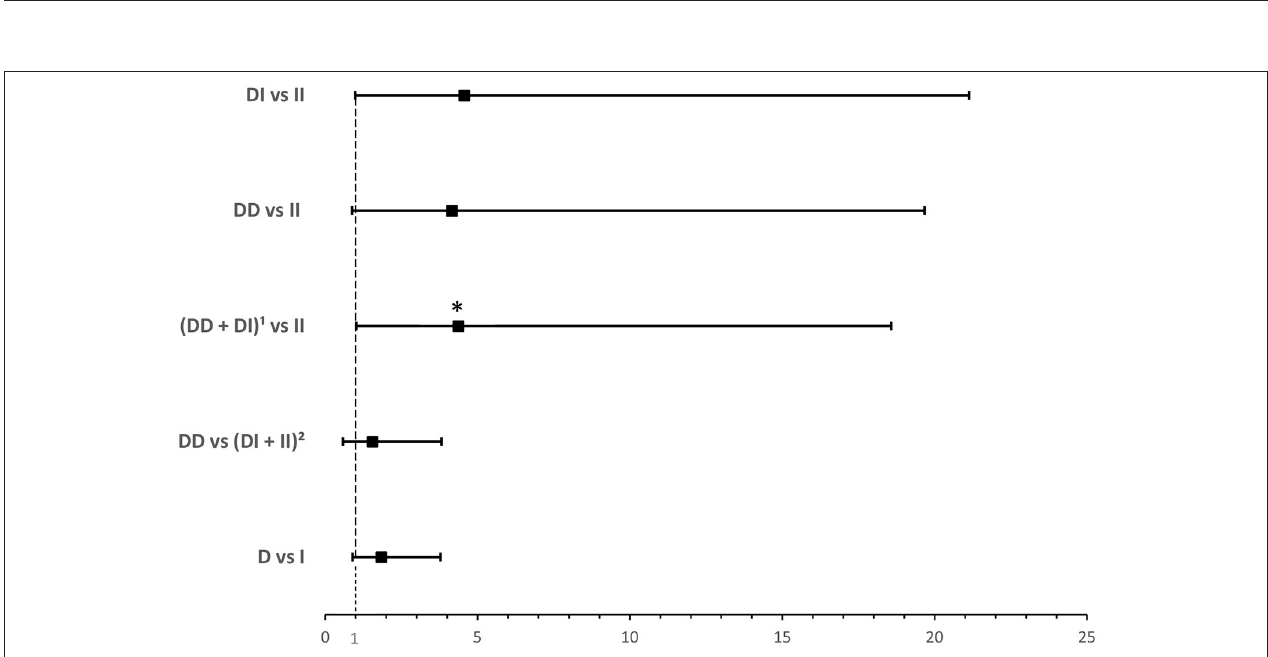
FIGURE 4 | Forest plot showing adjusted odds ratios ± 95% confidence intervals of ACE1 polymorphism for developing hypoxia in hospitalized COVID-19 cases. Multivariate analysis adjusted for BMI; * P < 0.05. 1 D allele carriers. 2 I allele carriers.